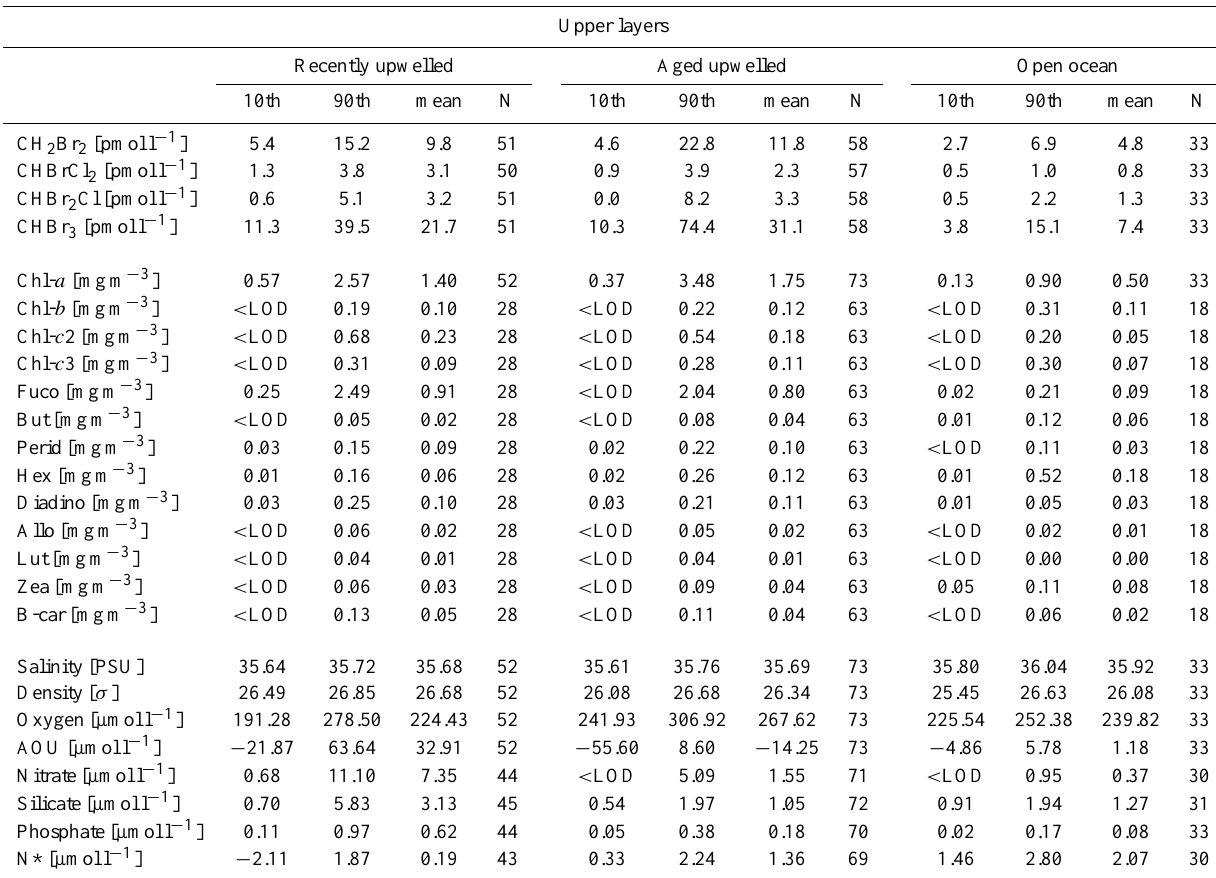
Table 1. The range (10th and 90th percentiles) and mean of bromocarbon concentrations and selected physical, chemical and biological variables in the Iberian upwelling. Data grouped by sampling depth (upper layers: surface to chlorophyll maximum; lower layer: below chlorophyll maximum) and water mass with indicated temperature anomalies (difference between SST of a water mass and all